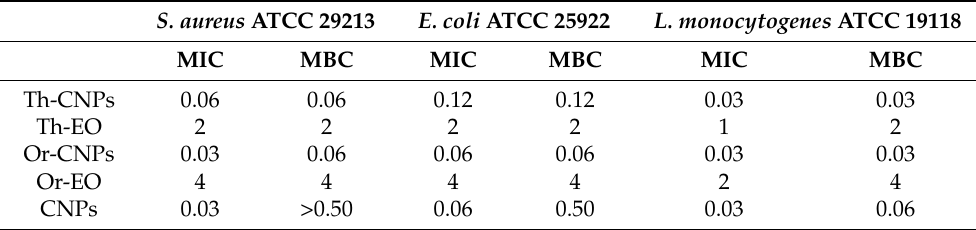
Table 1. MIC a and MBC a of essential oils chitosan nanoparticle suspensions (EO-CNPs) and empty chitosan nanoparticle suspensions (CNPs) against different microbial